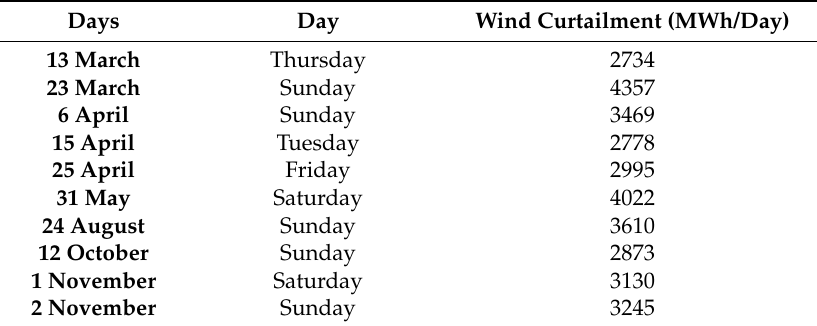
Table 8. Days with highest wind